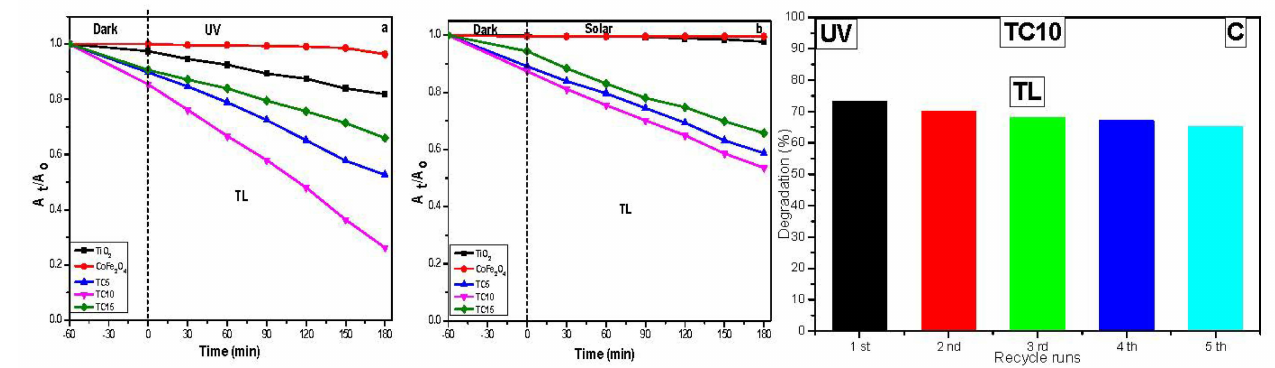
Figure 11. Photocatalytic oxidative degradation of tetracycline under ( a ) UV, ( b ) visible light irradia- tion using the prepared photocatalysts and ( c ) Reusability tests for the degradation efficiency of TL under UV for 5 subsequent